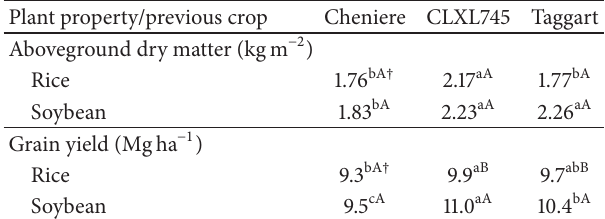
Table 3: Mean aboveground dry matter and yields collected at harvest (24 October, 2013) from Cheniere, CLXL745, and Taggart following previous crops of rice and soybean at the Northeast Research and Extension Center in Keiser,